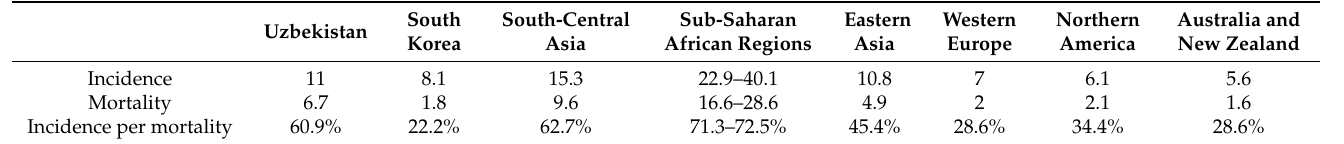
Table 3. Brief global statics of cervical cancer, including Uzbekistan and South